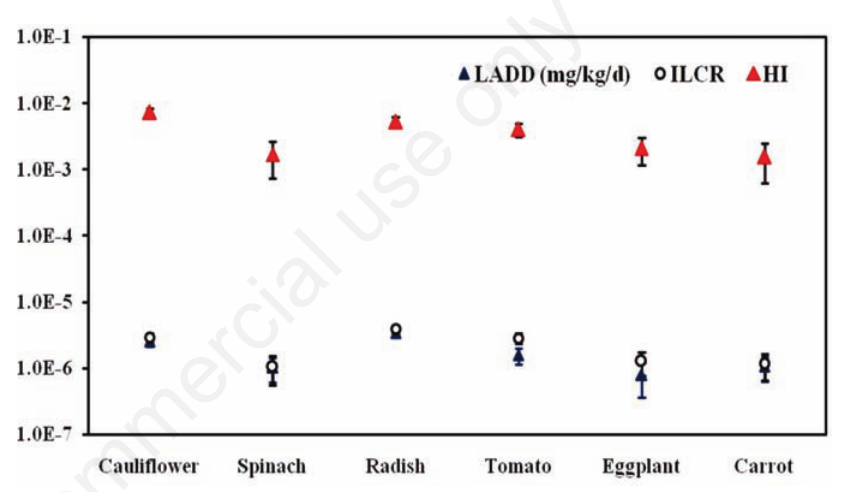
Figure 1. Comparative lifetime average daily dose (LADD), incremental lifetime cancer risk (ILCR) and hazard index (HI) for selected humans due to hexachlorocyclohexane and dichlorodiphenyltrichloroethane exposure through